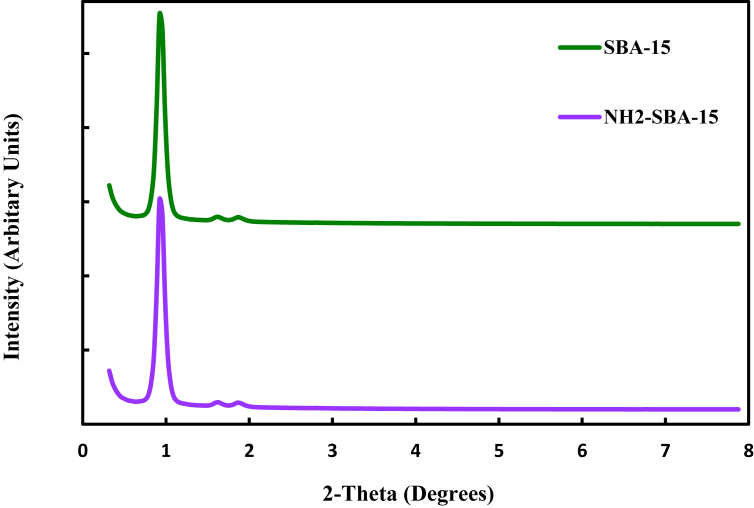
XRD patterns for SBA-15 and NH2–SBA-15.